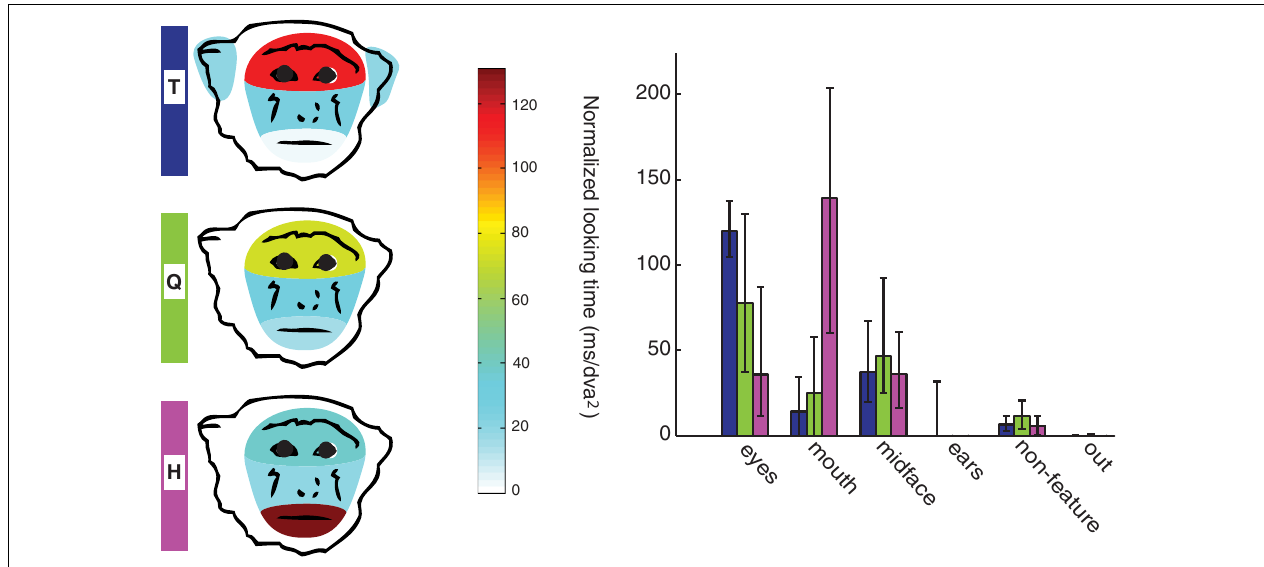
FIGURE 5 | Monkeys differ in amount of time spent looking in each face region. In the left panel, schematic drawings represent the distribution of looking time on four face regions for each of the three monkeys (looking data for these plots were averaged across facial expressions and gaze directions in order